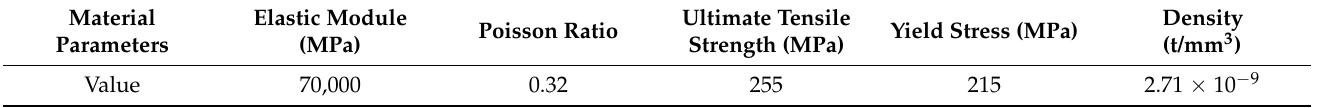
Table 1. Material parameters of the structure